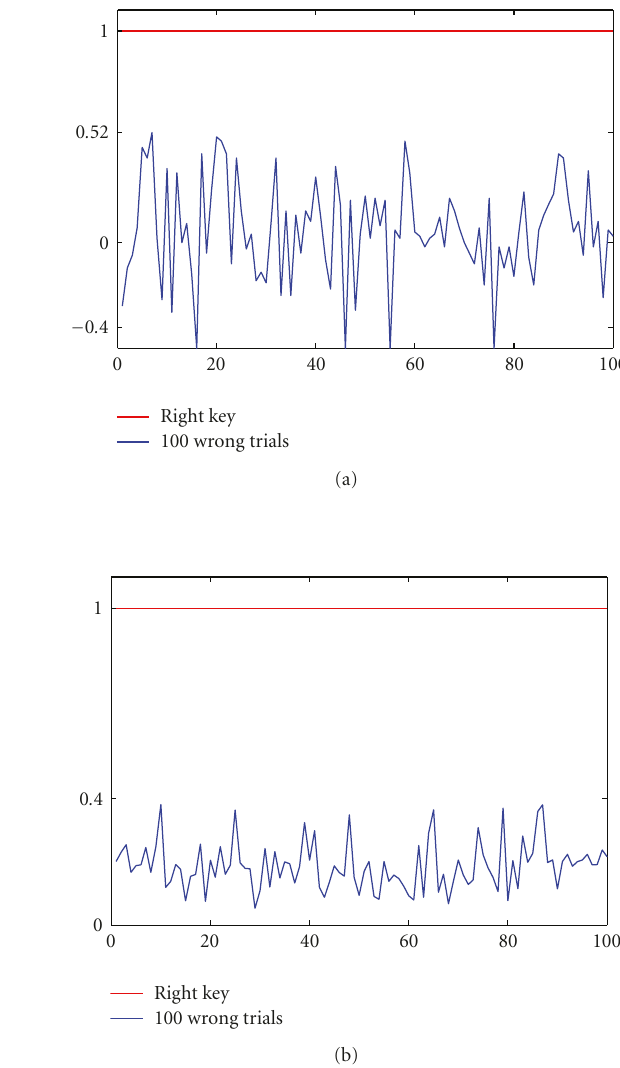
Figure 5: Detection results for watermark modeled to follow middle frequency formants (a) f max = 4kHz, (b) f max = 11.025 kHz.